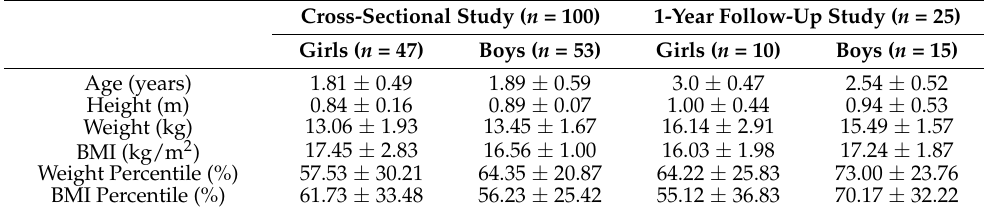
Table 1. Participants characteristics.